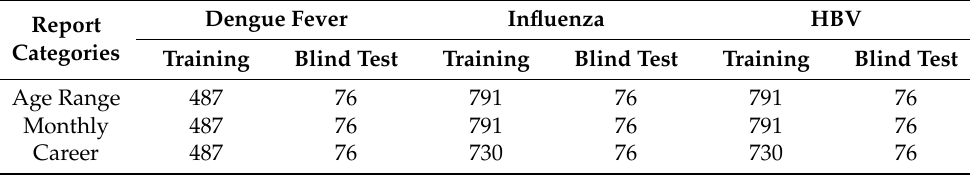
Table 5. Number of training and blind test datasets.